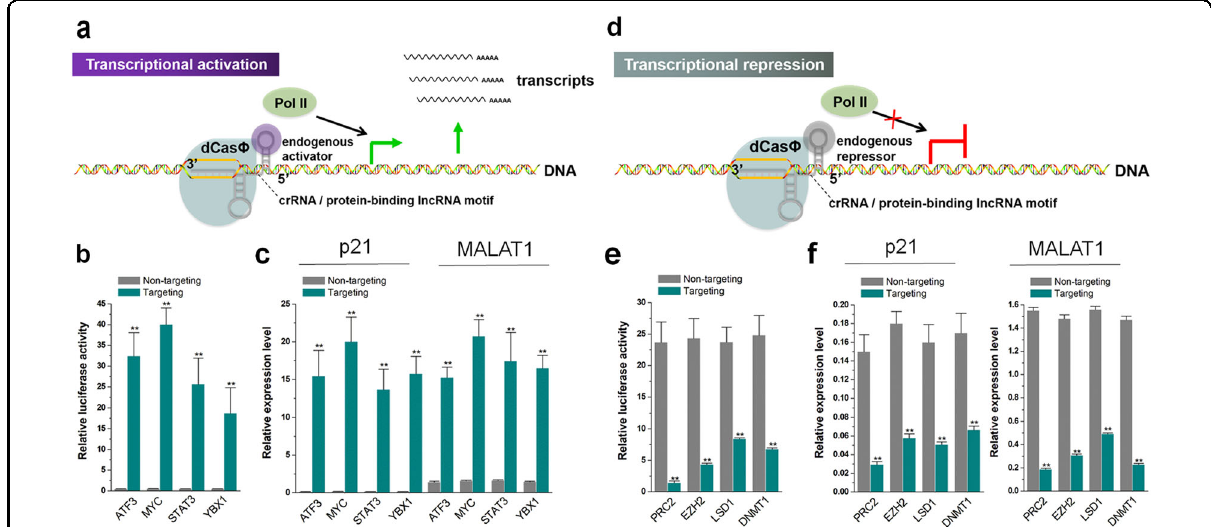
Fig. 2 Endogenous transcription factors regulate gene activation/inactivation. a Schematic diagram showing the molecular mechanism underlying enhanced transcription of cellular genes accomplished by binding endogenous transcription activators. b The effect of gene activation was determined by dual-luciferase reporter assay. Relative luciferase activities were determined as the ratios between Rluc and Fluc values. c The relative expression levels of P21 and MALAT1 upregulated by endogenous transcription activators were determined by real-time quantitative PCR (RT-qPCR). d Schematic diagram showing the molecular mechanism leading to repressed transcription of cellular genes by binding endogenous transcription repressors. e The effect of gene inactivation was detected by the dual-luciferase reporter assay. f The relative expression levels of p21 and MALAT1 were downregulated by endogenous transcription repressors, compared to the control, as determined by RT-qPCR. The results are shown as the means ± SD. Each experiment was performed in triplicate for fi ve independent times. * P < 0.05; ** P < 0.01, compared to the control, two-tailed t